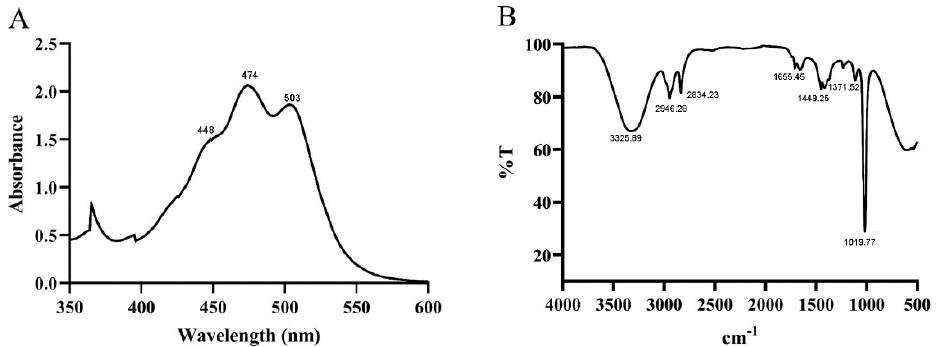
Figure 2. UV-Vis ( A ) and FT-IR ( B ) spectrum of the purified pigment from G. rubripertincta GH-1. Figure 2. UV‑Vis ( A ) and FT‑IR ( B ) spectrum of the purified pigment from G. rubripertincta